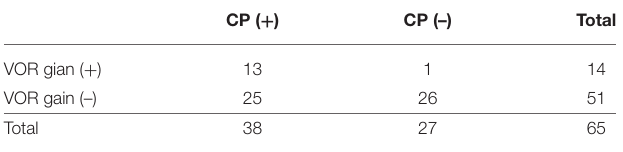
TABLE 3 | Results of vHIT and Caloric test in